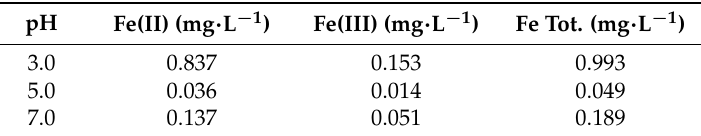
Table 1. Fe(II) and Fe(III) concentrations in water at different pH values from MH1.0 (200 mg · L − 1 ) suspension after 12